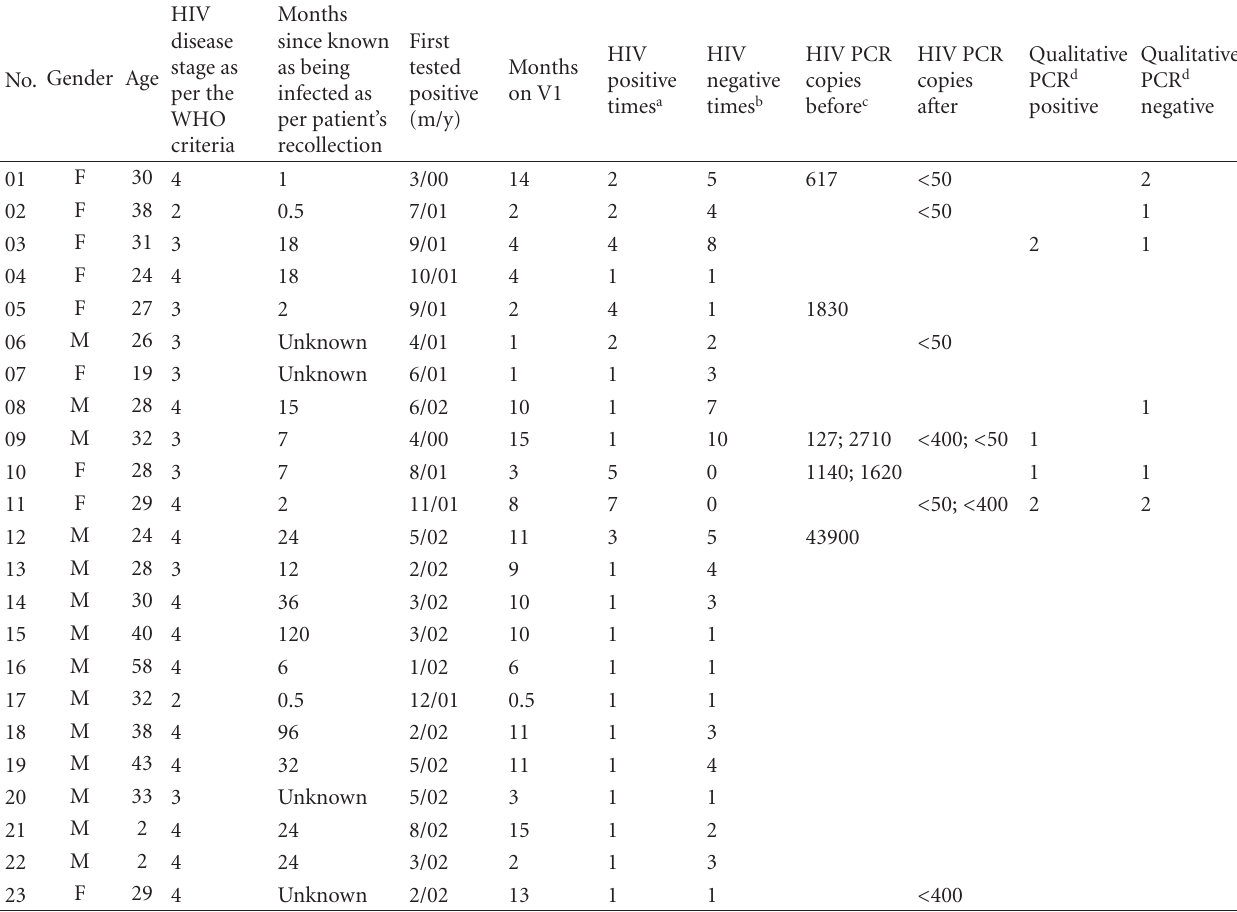
Table 1: Summary of lab tests on serodeconverted HIV-positive patients treated with V1.